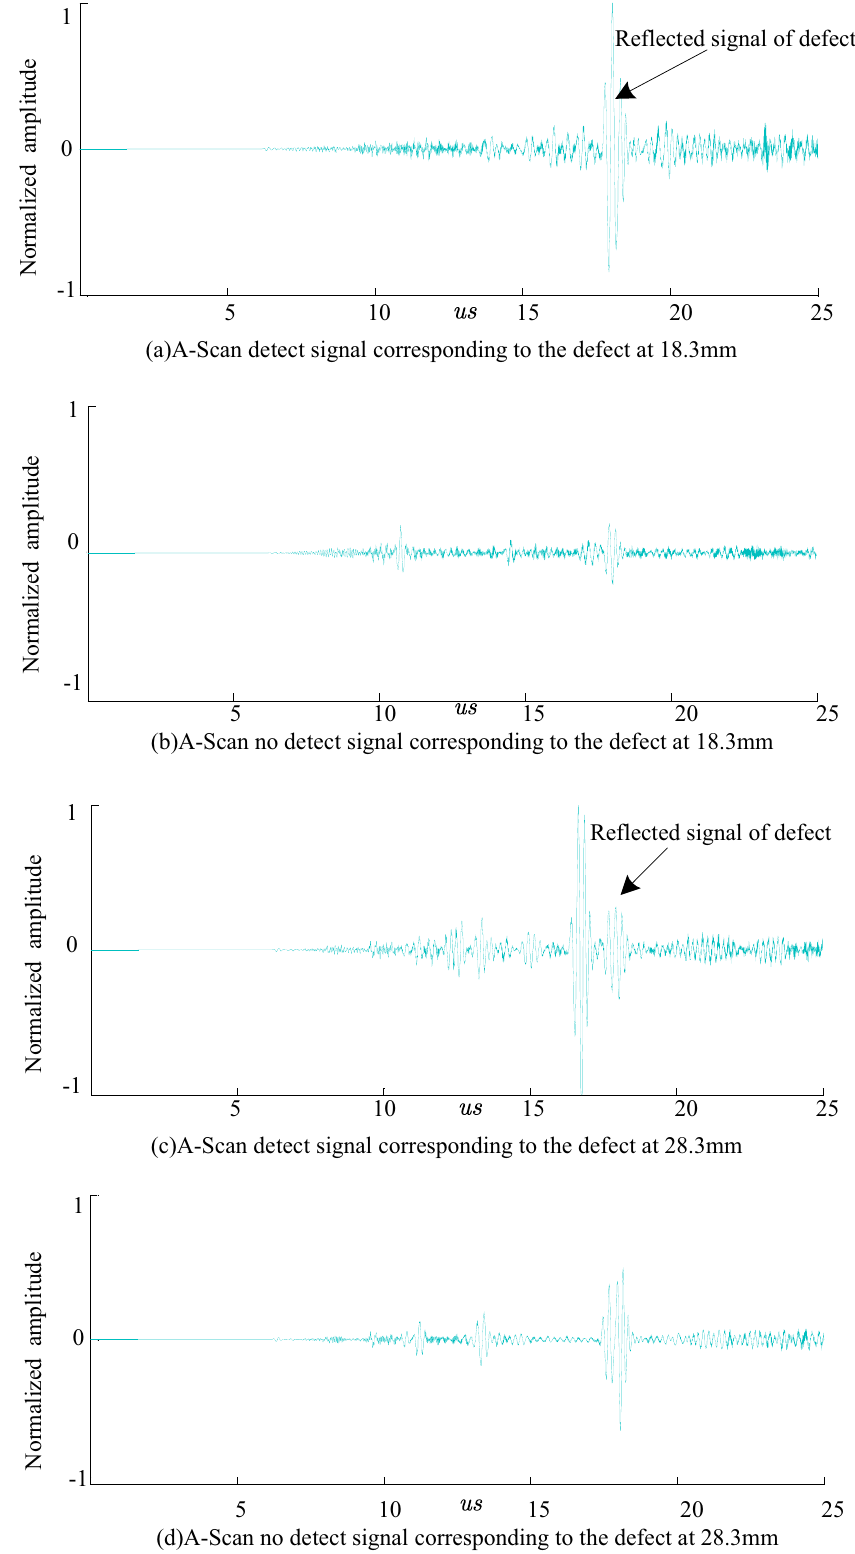
Figure 13. Simulation result of the planar defect detection with the dual array